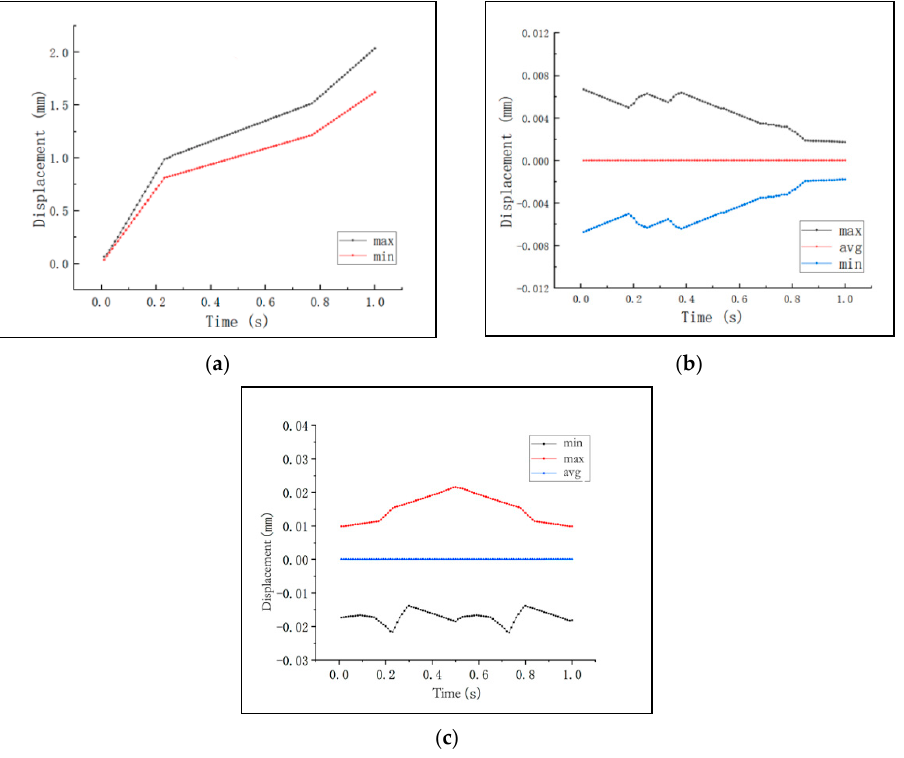
Figure 8. Motion displacement curve of z -axis mechanism; ( a ) the z -axis displacement; ( b ) the x -axis displacement; ( c ) the y -axis displacement.